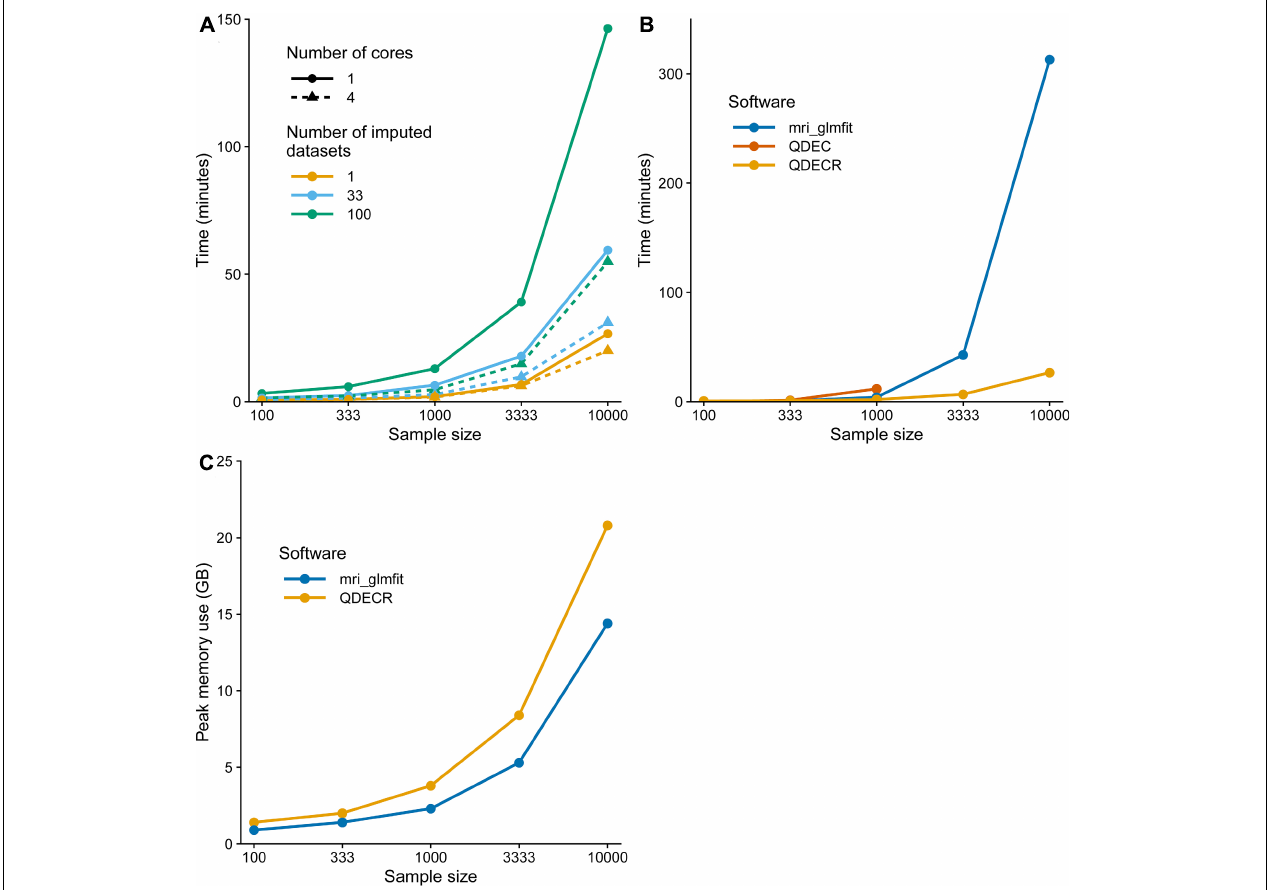
FIGURE 4 | Computation time benchmark of the QDECR package. (A) Displays the computation time of an analysis with QDECR when varying sample size, number of cores (threads) used and number of imputed datasets that were included. (B) Compares the computation time for mri_glmfit, QDEC and QDECR when using a single core (thread) and unimputed data. For QDEC we used the time that the analysis took, without loading or assembling of the data or the multiple testing correction. For mri_glmfit we measured the time it took to run three commands: (Fan and Markram, 2019) mri_preproc to assemble the FreeSurfer output, (Wright et al., 1995) mri_glmfit to run the analysis and (Dale and Sereno, 1993) mri_glmfit-sim to perform the multiple testing correction. **Note: QDEC returned errors when attempting to run the analyses on 3,333 and 10,000 participants and is thus not represented for those sample sizes in panel (B) . (C) Compares the peak